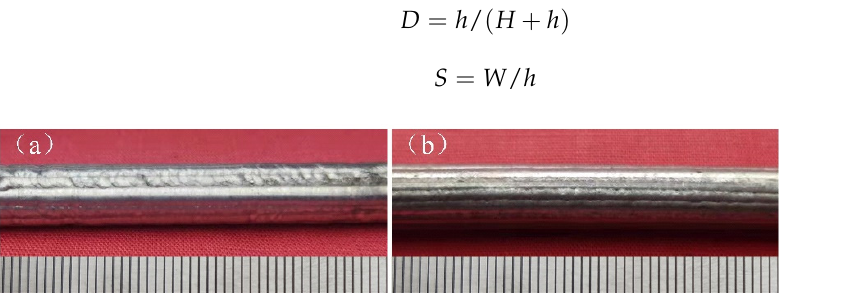
Figure 3. The cladding appearance images: ( a ) the underwater cladding layer; ( b ) the in-air cladding layer.